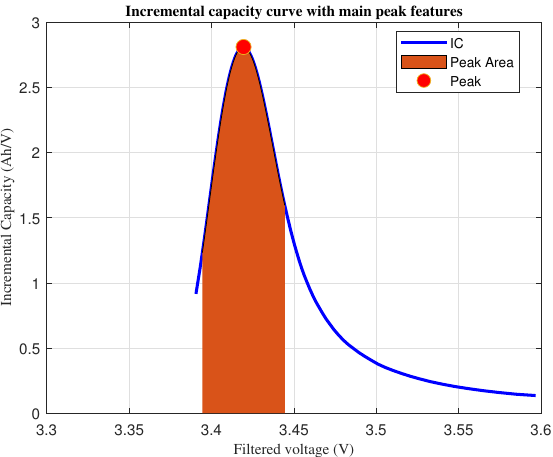
Figure 3. Incremental capacity curve sample with main peak features